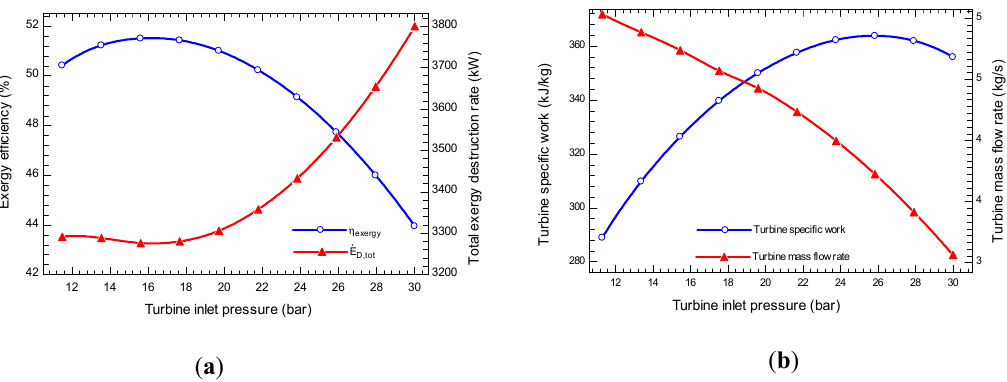
Figure 4. The e ff ect of the TIP ( a ) on exergy e ffi ciency and total exergy destruction rate ( b ) on the Figure 4. The effect of the TIP ( a ) on exergy efficiency and total exergy destruction rate ( b ) on the turbine specific work and mass flow turbine specific work and mass flow rate.